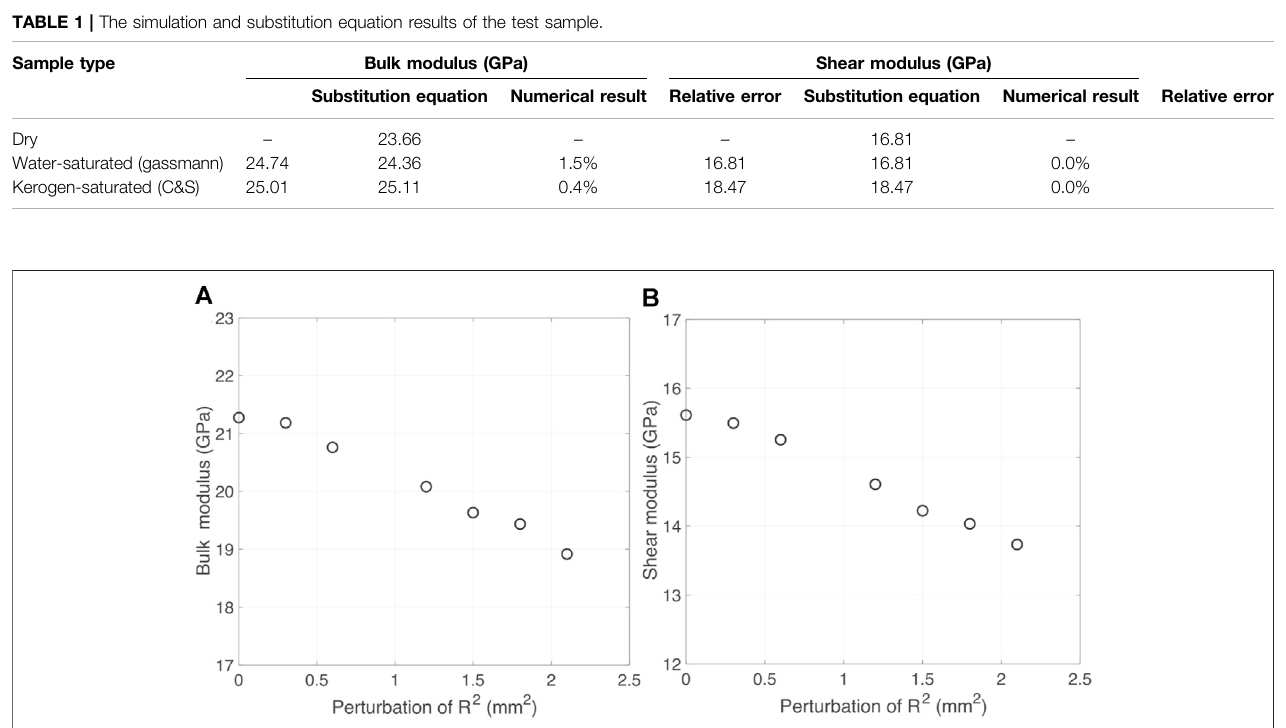
Table 1 . The numerical error between the substitution equations and numerical results are less than 0.4% for the elastic moduli of kerogen-saturated sample, and the shear modulus of water-saturated sample. The numerical error between Gassmann equation and numerical result is 1.5%